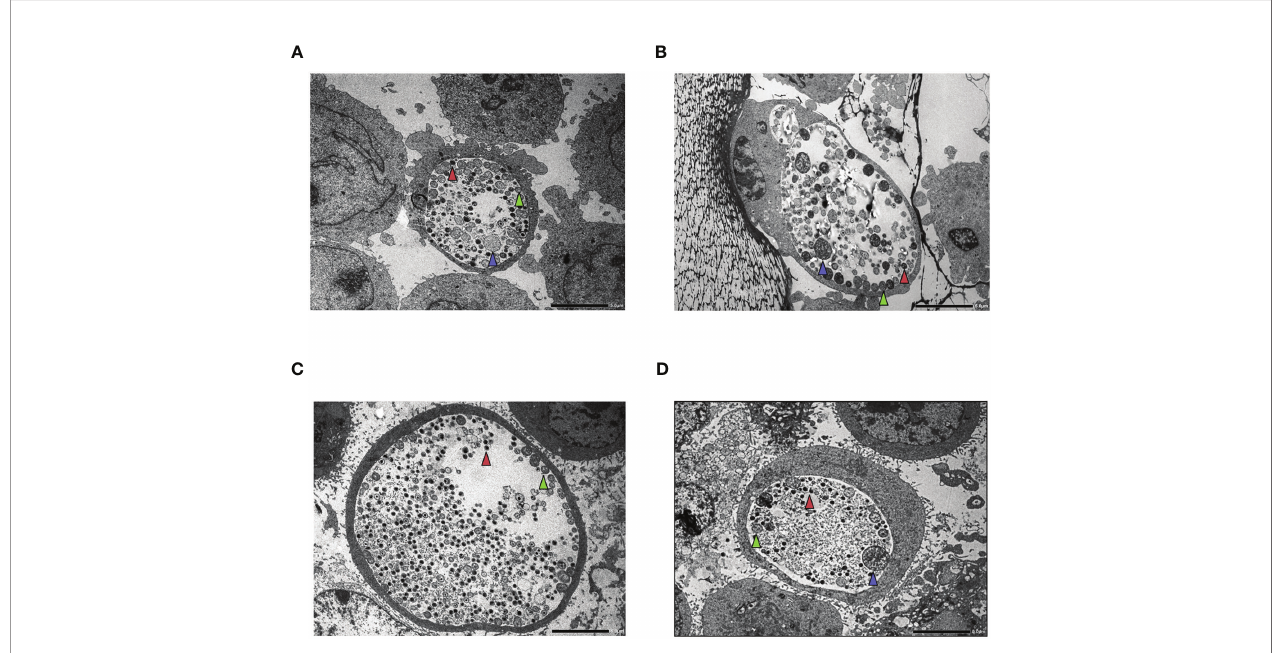
FIGURE 7 | Transmission electron microscopy (TEM) of HL-60 and HeLa cells. Cells were infected with Chlamydia trachomatis (multiplicity of infection, 4) and were treated with 20 IU/ml interferon-gamma (IFNG) or left untreated. TEM was performed at 48 h post-infection. (A) C. trachomatis -infected HL-60 cell. (B) C. trachomatis -infected and IFNG-treated HL-60 cell. (C) C. trachomatis -infected HeLa cell. (D) C. trachomatis -infected and IFNG-treated HeLa cell. Red triangle, elementary body; green triangle, reticulate body; blue triangle, enlarged reticulate body or persistent body. Bar is 5 m